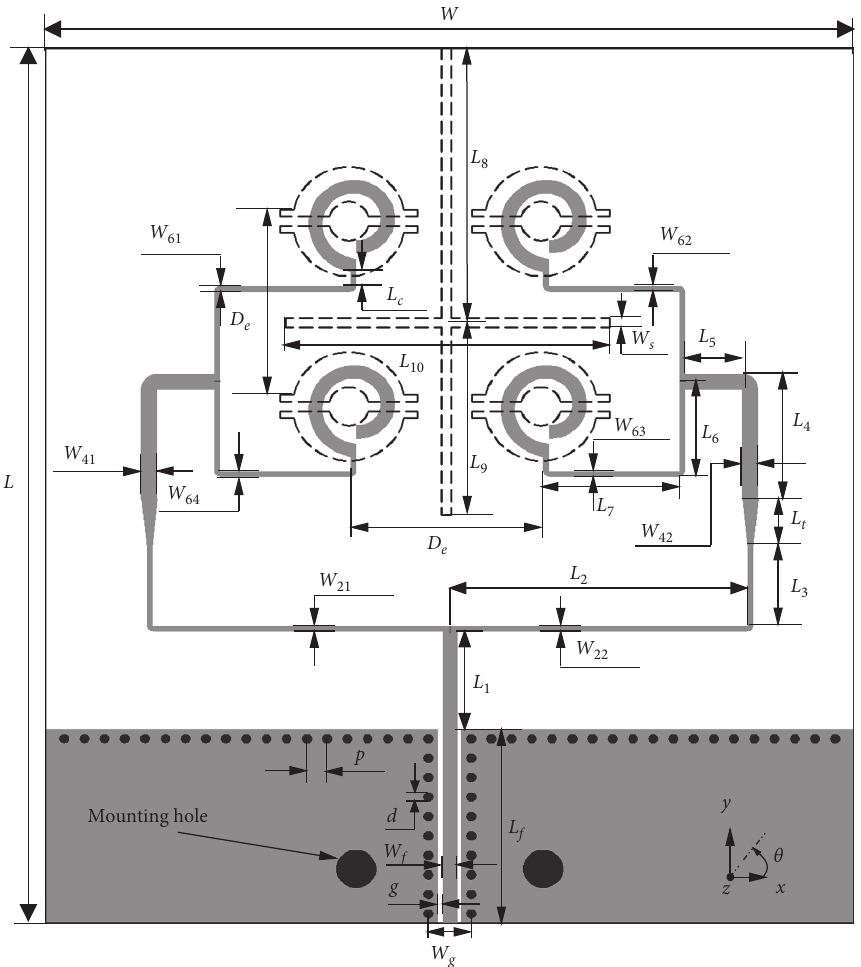
Figure 1: Geometry of the proposed mmWave wideband CP antenna array.